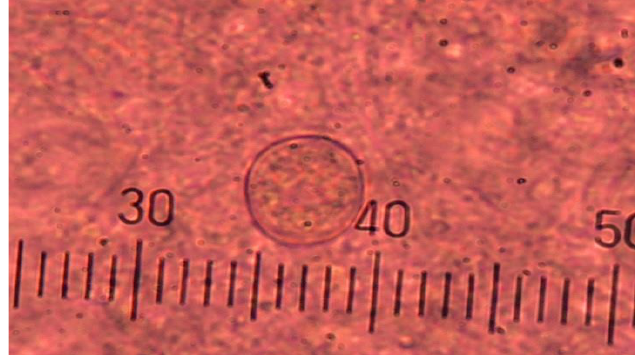
Figure 7. Non sporulated Eimeria sordida oocyst is seen using the method of floatation with Sheather's solution (40×)